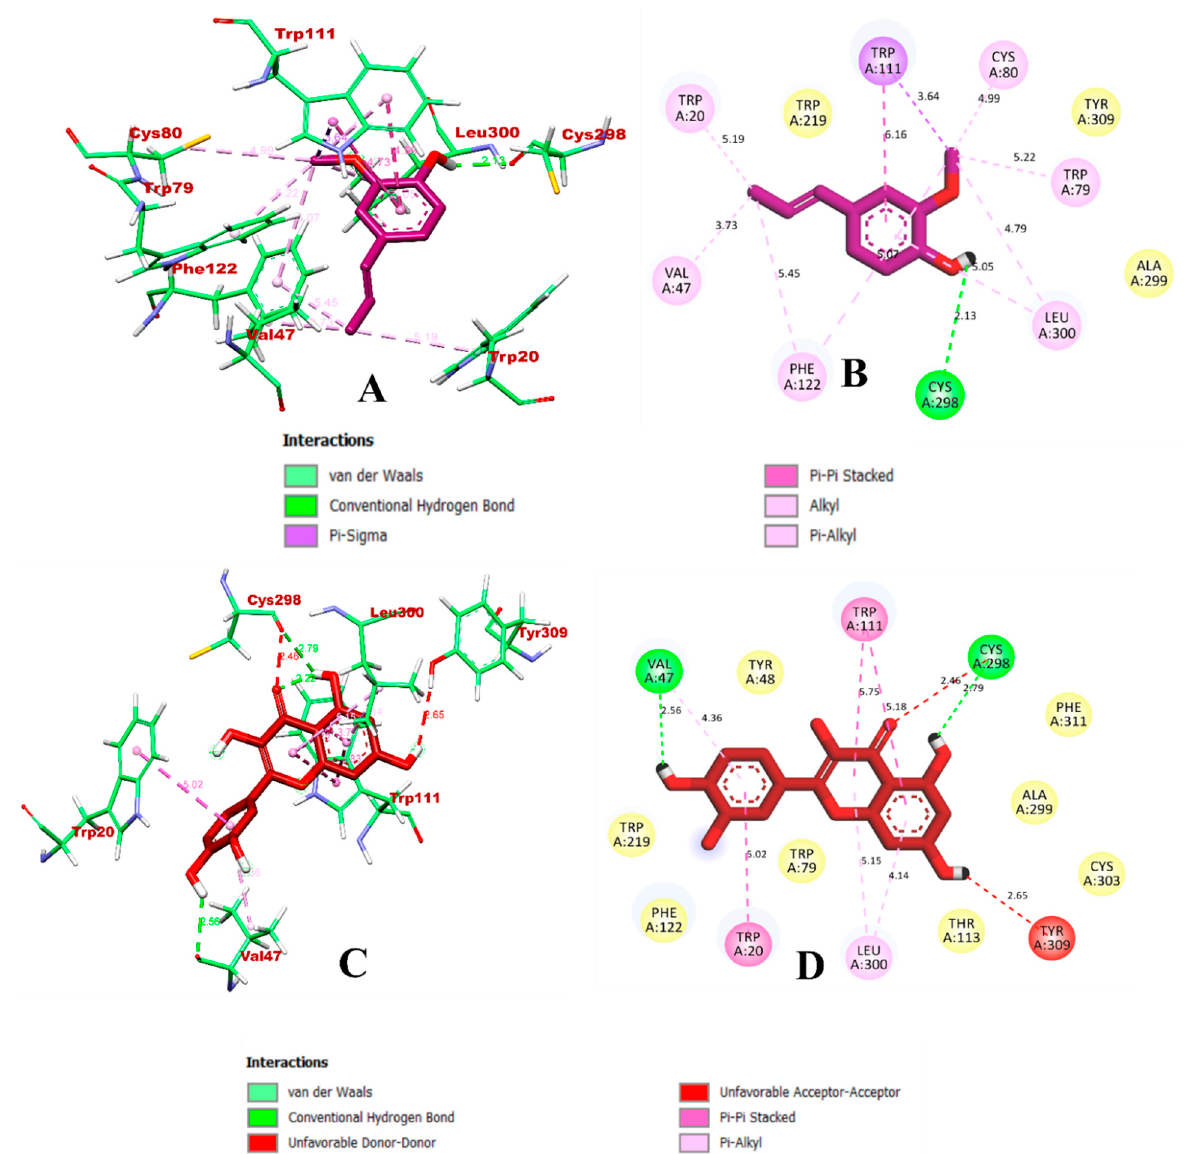
Figure 3. Visualization of the docking simulation of compounds with HAR. ( A , B ) Interaction of isoeugenol (purple) visualized in 3D and 2D, respectively. ( C , D ) Interaction of quercetin (red) visualized in 3D and 2D, respectively.